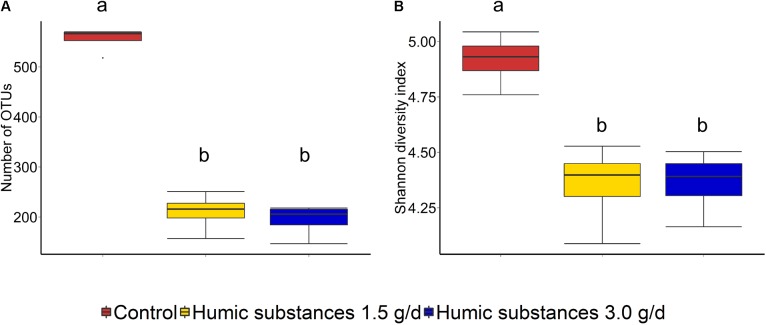
Box plots of the (A) number of OTUs and (B) Shannon diversity index for liquid-associated microbe (LAM) samples by treatment at day 15. Different lowercase letters within each sampling time indicate significantly different means (P < 0.05).